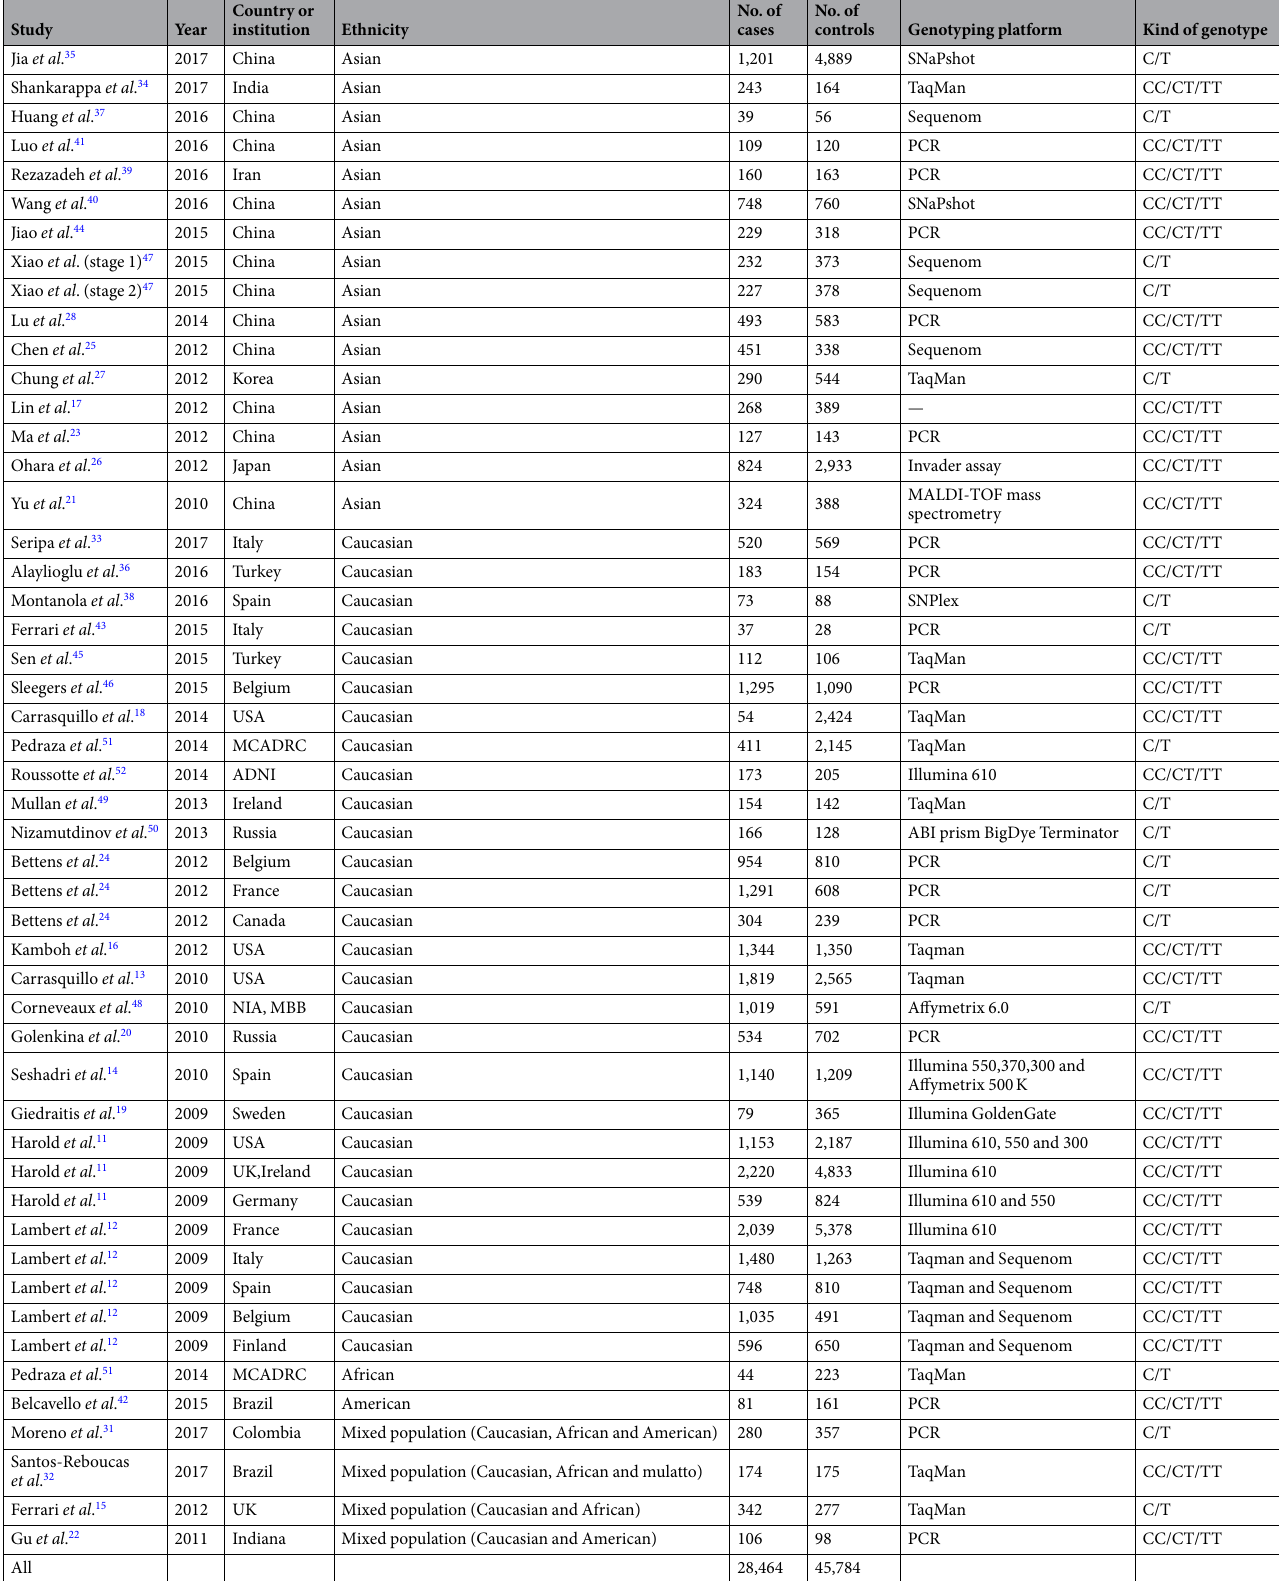
Table 1. Main information of the studies included in this meta-analysis. “CC/CT/TT” means the study offer the data of genotypes CC, CT and TT both in cases and controls. “C/T” means only the data of genotypes C and T are offered in the study. MCADRC: Mayo Clinic Alzheimer’s Disease Research Center; ADNI: Alzheimer’s Disease Neuroimaging Initiative; NIA: National Institute on Aging; MBB: Miami Brain